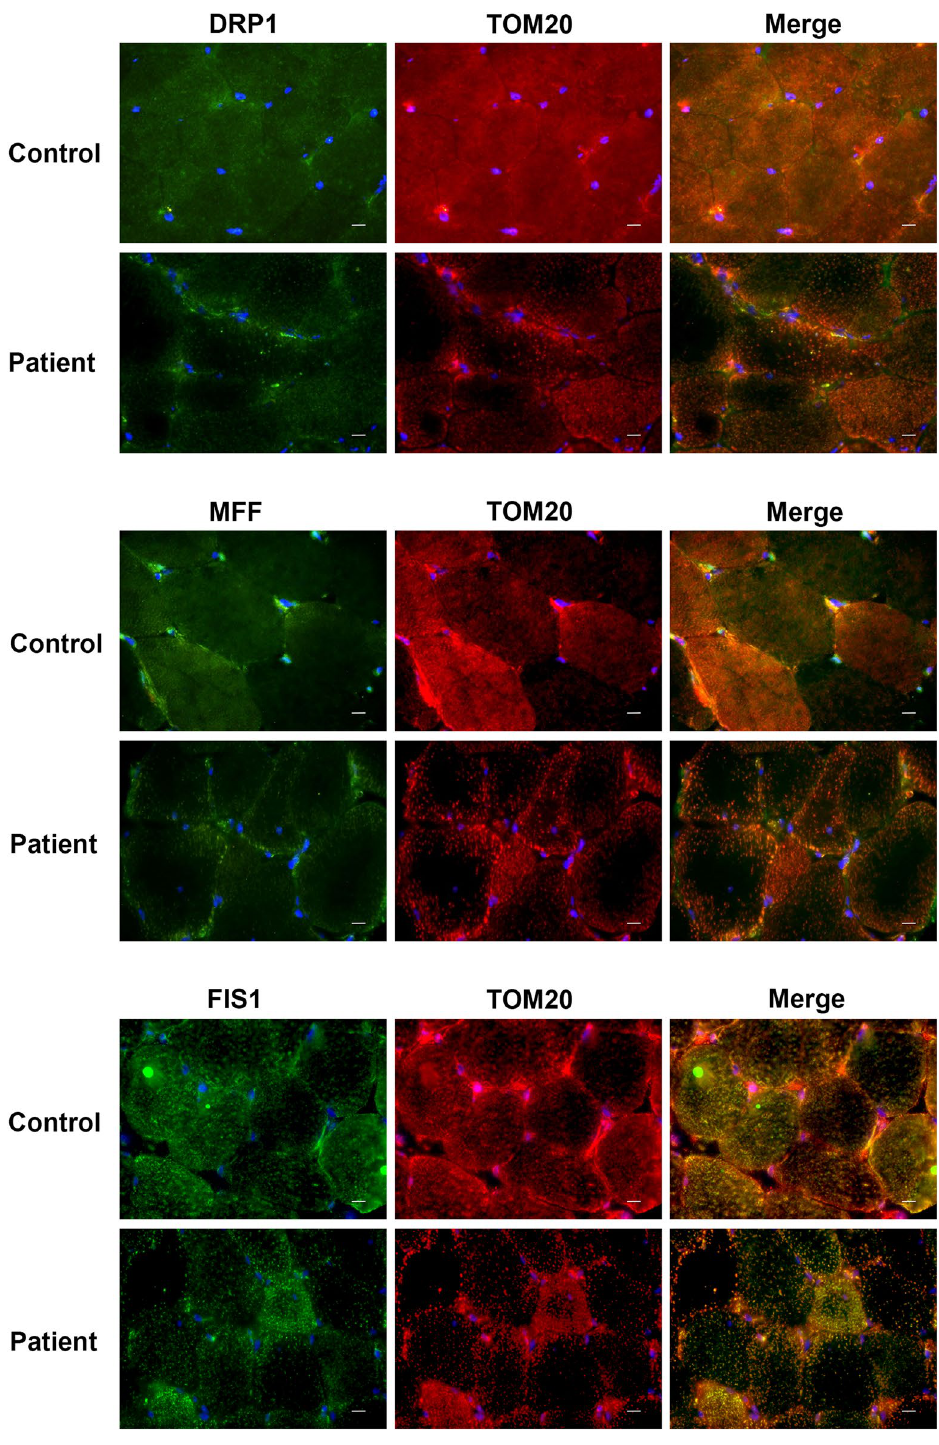
Figure 6. Immunofluorescence analysis of mitochondrial fission proteins in skeletal muscle tissue sections of the Megaconial CMD patient. Left panel: Green/FITC: DRP1, MFF and FIS1 (top to bottom); Middle panel: Red/Texas Red: TOM20/mitochondria; Right panel: Merged images, Blue: DAPI/nuclei. Scale bars: 10